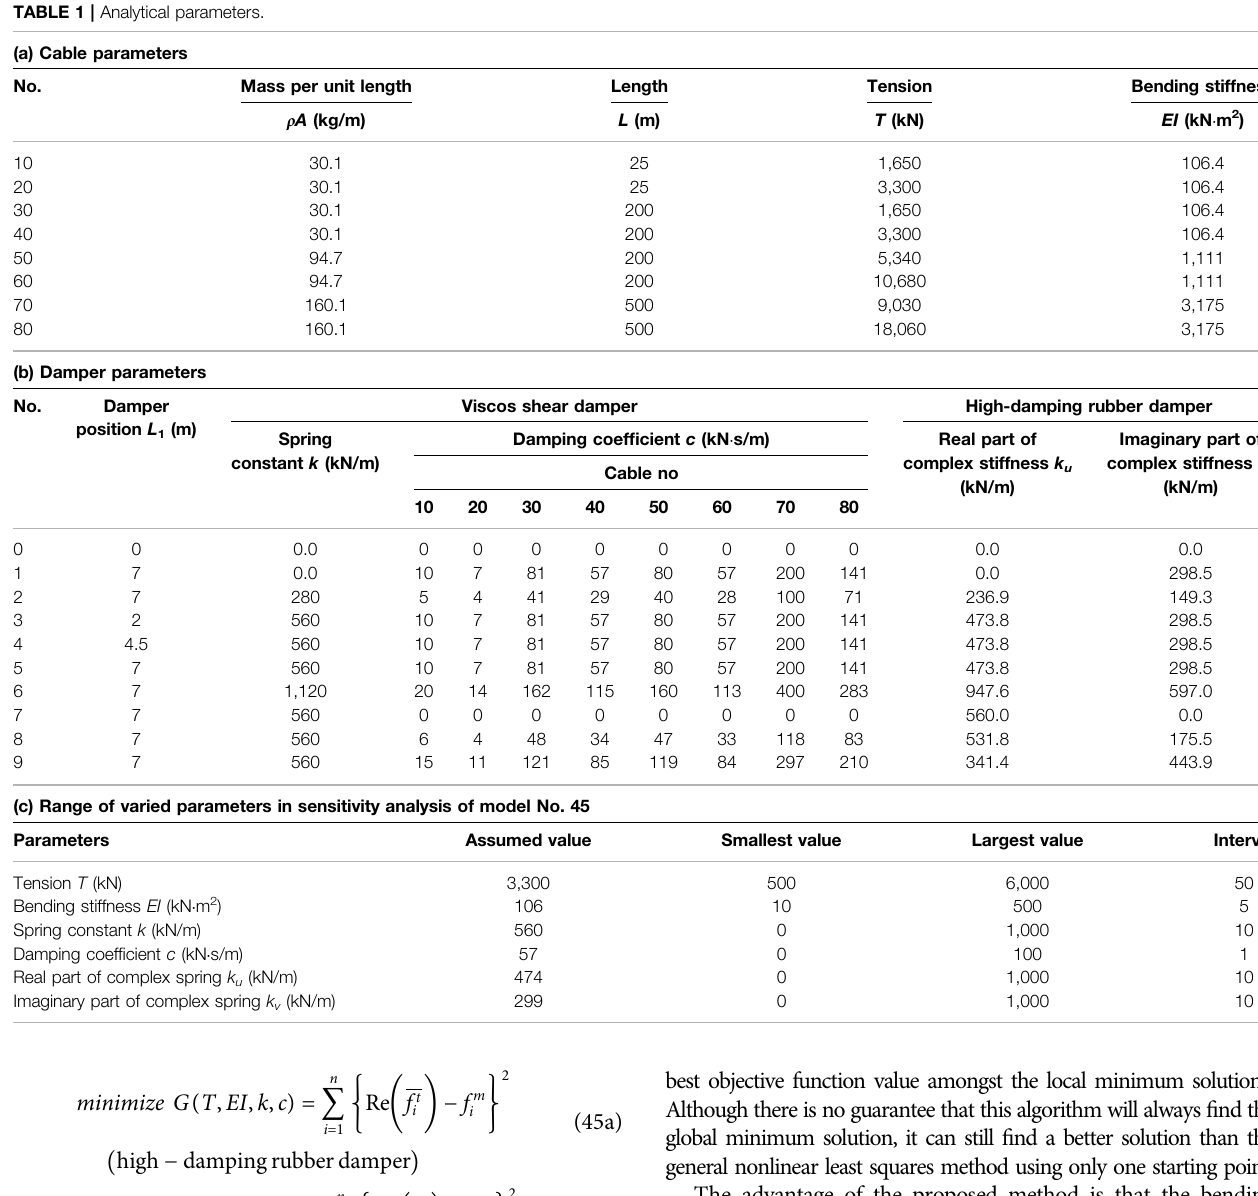
TABLE 1 | Analytical